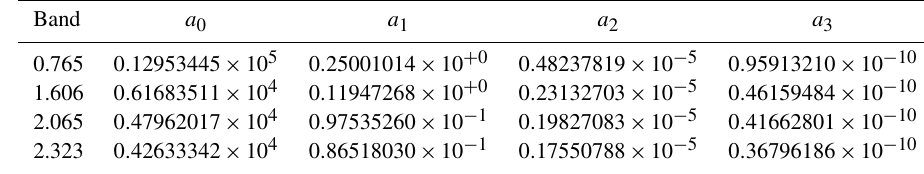
Table 5. Dispersion coefficients a k for the geoCARB bands. Band a 0 a 1